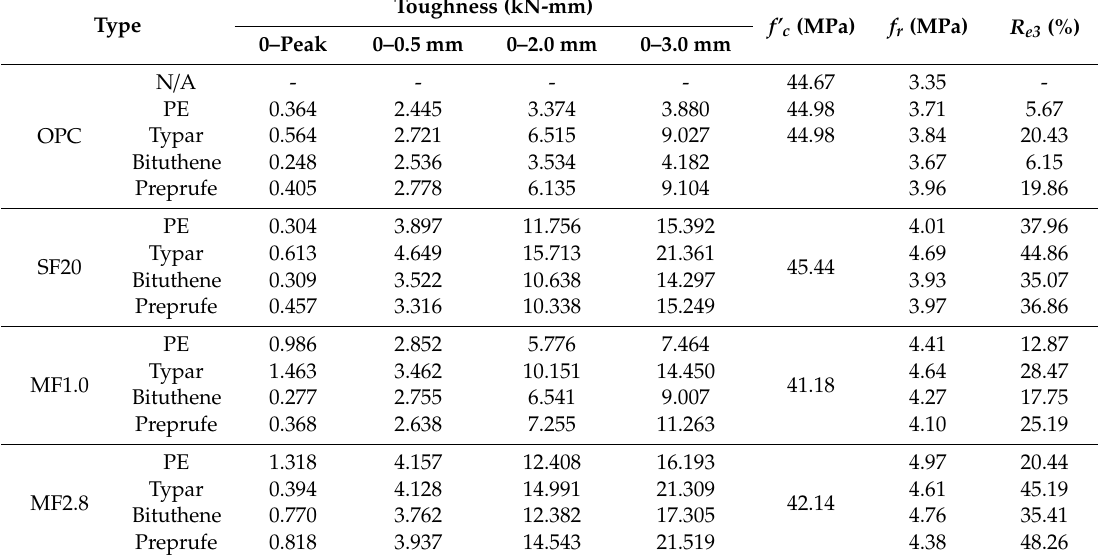
Figure 6. Load-displacement curve during crack propagation (MF 2.8). Table 6. Summary of flexural test performance.